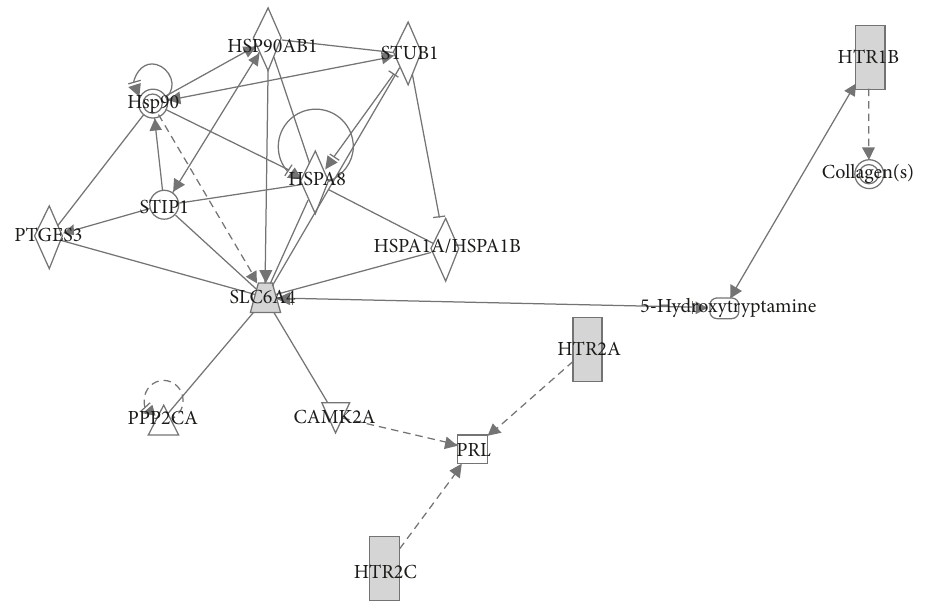
Figure 3: Network analysis found four serotonin receptors, HTR1B, SLC6A4, HTR2A, and HTR2C, significantly associated with OSA. Ingenuity Pathway Analysis was used to create a network analysis. Links of validated genes (in grey) and other genes or molecules are represented with a continuous (direct interaction) or discontinuous line (indirect interaction). The expression of our candidate genes could be modulated mainly by 3 molecules: 5-hydroxytryptamine (for HTR1B and SLC6A4), PRL (HTR2A and HTR2C), and HSP90AB1 (for SL6CA4).